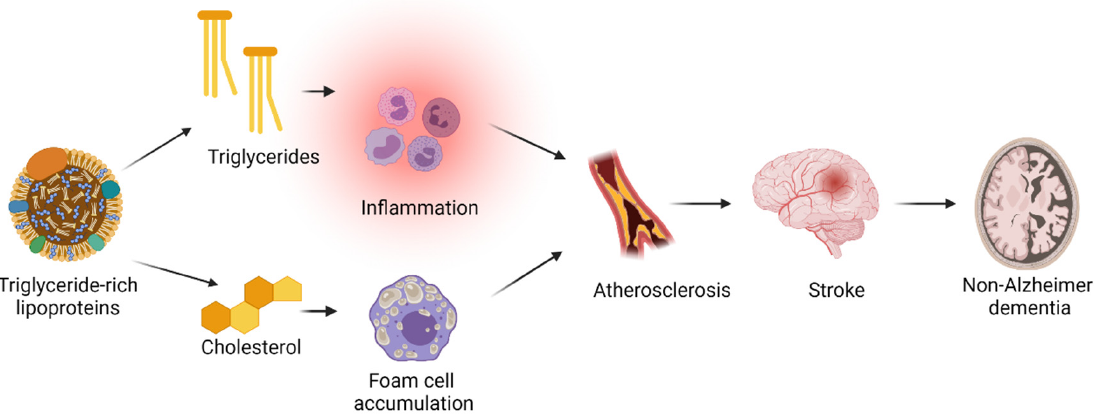
Figure 3. A proposed explanation for the association between high plasma triglycerides and a high risk of stroke and non-Alzheimer dementia. Triglyceride concentration reflects the triglyceride content in triglyceride-rich lipoprotein particles, and thus, also the cholesterol content in these particles. The cholesterol content can be taken up by macrophages leading to foam cell formation. These foam cells get trapped in the arterial wall and lead to the formation of an atherosclerotic plaque. The triglyceride content of triglyceride-rich lipoprotein particles can cause inflammation, and thus, further contributing to the formation of atherosclerosis. Atherosclerosis causes ischemic stroke which, again, causes non-Alzheimer dementia. Created with